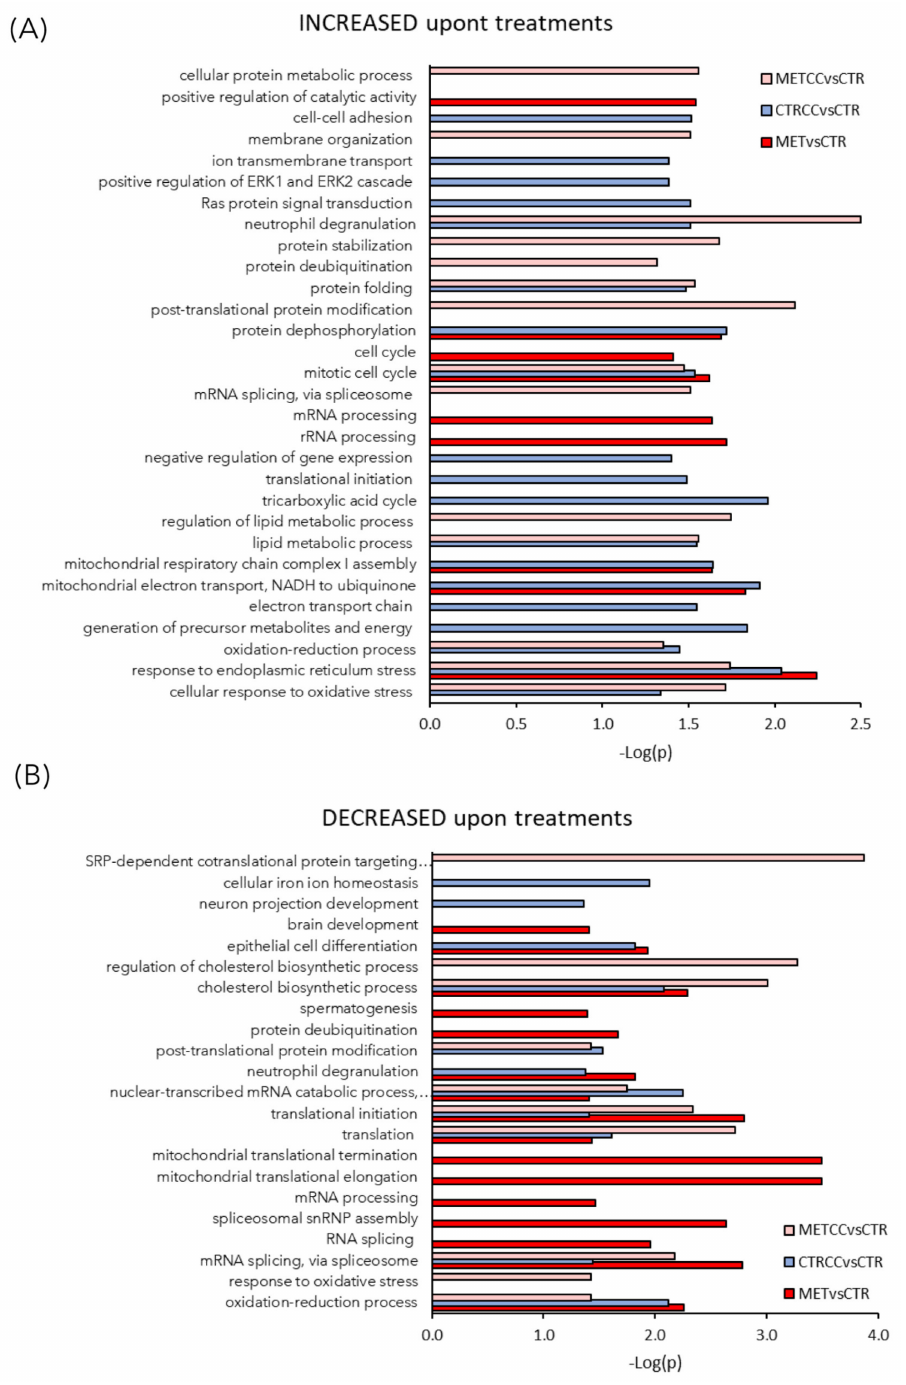
Figure 2. High methionine and Compound C induce proteomic changes. (A–C) Functional analysis of the proteins di ff erentially expressed in the comparison MET versus CTR, METCC versus MET, CTRCC versus CTR. Proteins were considered di ff erentially expressed if they were present only in one condition or showed significant t -test di ff erence (Student’s t -test p value = 0.05). ( A ) GO Biological Processes increased in the three comparison ( B ) GO Biological Processes decreased in the three comparison. Functional grouping was based on Fischer’s exact test p -value ≤ 0.05 (i.e., − log10 ≥ 1.3) and at least three counts. In each comparison, the terms increased or decreased refer to proteins up or downregulated upon